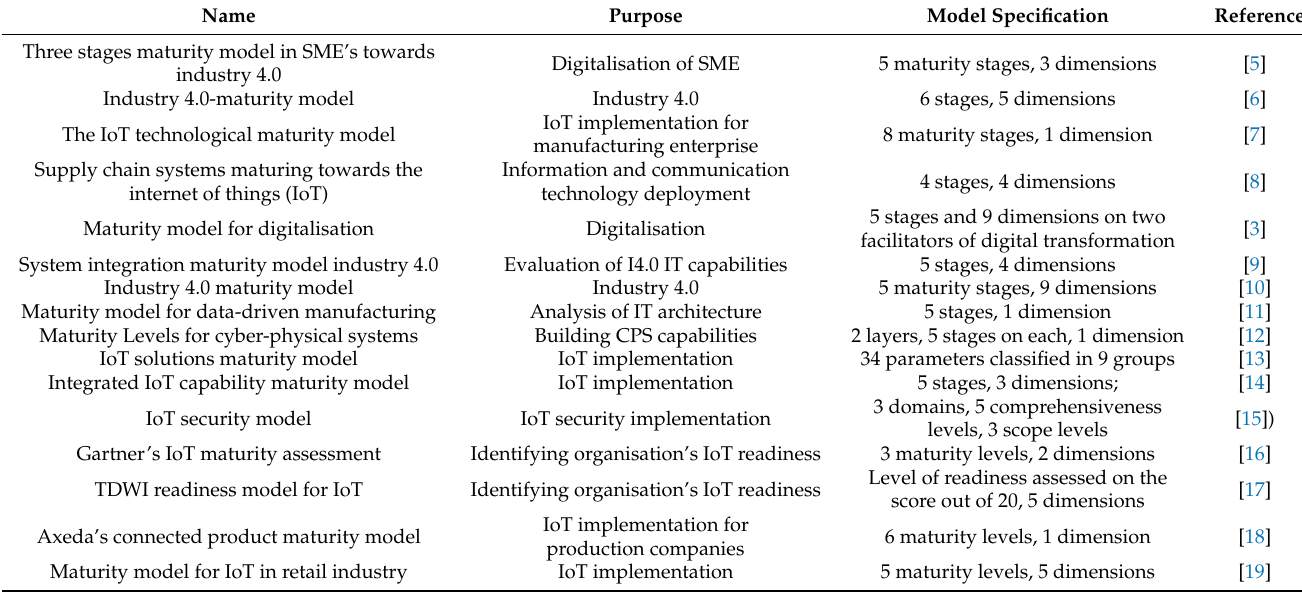
Table 1. Reviewed maturity